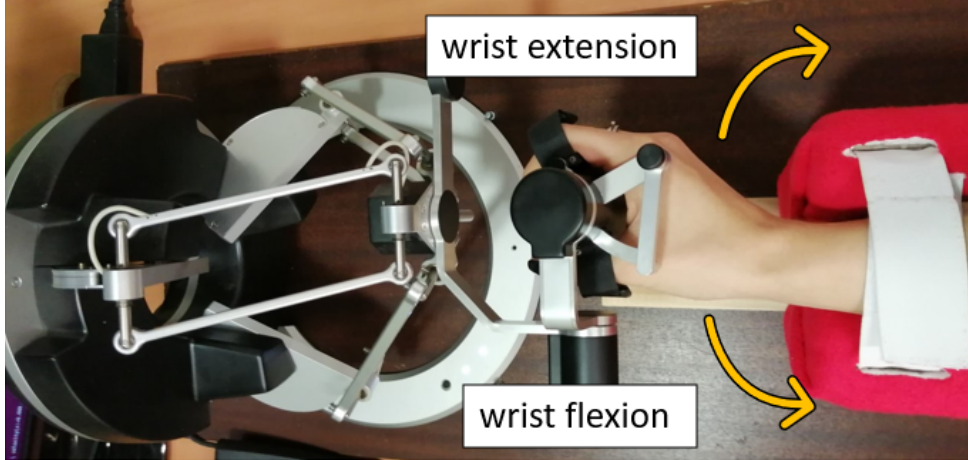
Figure 8. Interpretation of flexion and extension direction on the example of the right